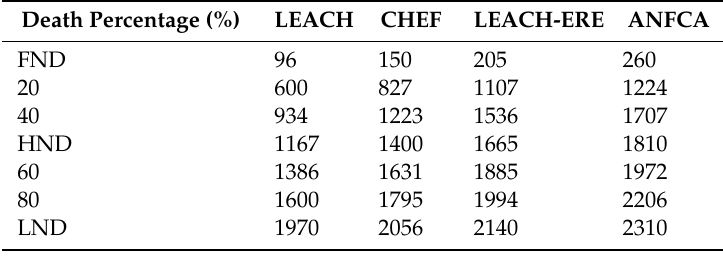
Table 3. Node death rate percentages up to 2500 rounds.